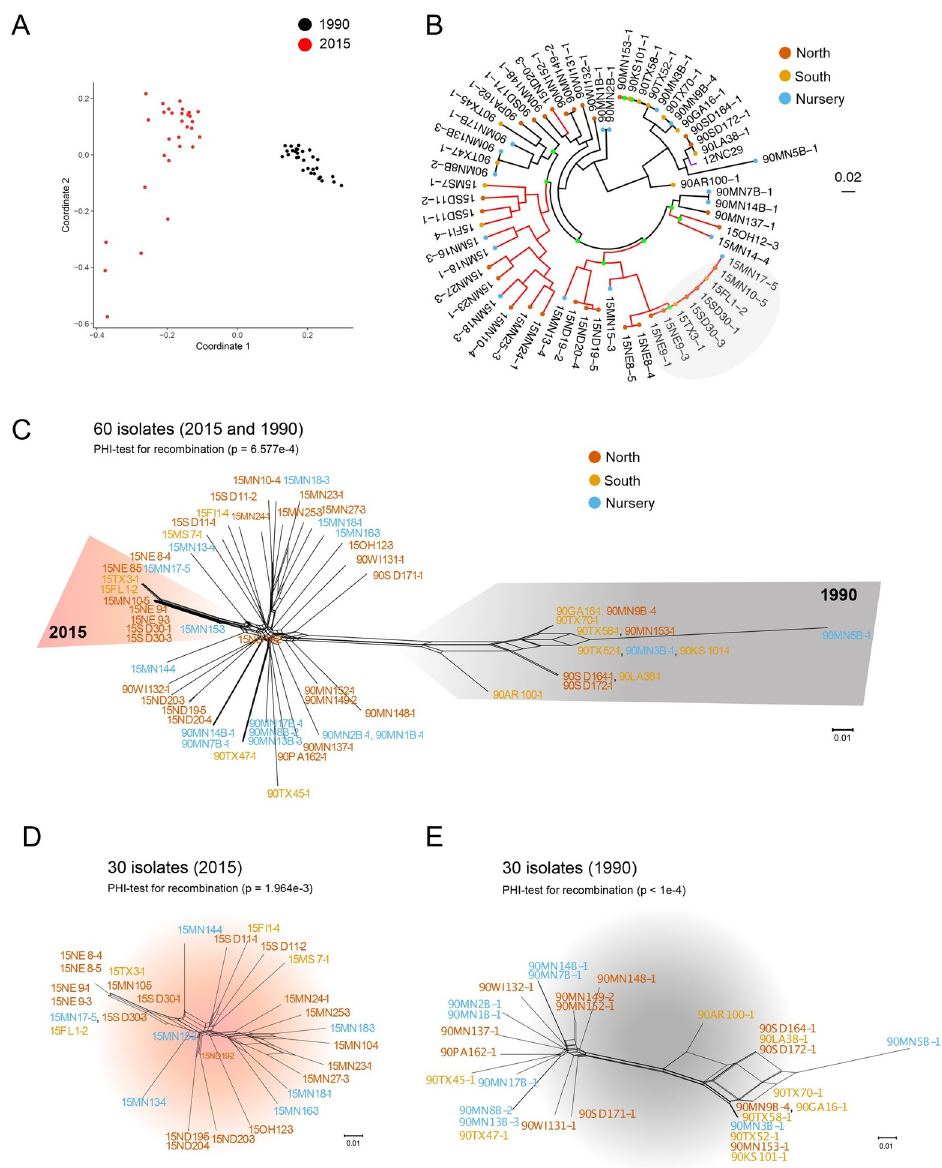
Fig 2. Population structure of Puccinia coronata f. sp. avenae in the US. (A) kWIP Genetic distance matrix of combined isolates from 1990 (black) and 2015 (red) collections. (B) Phylogenetic analysis using a maximum likelihood model with 2,582,690 variant sites and 500 bootstraps. The 1990 population is shown in black branches and the 2015 population is shown in red branches, with a purple branch for isolate 12NC29. Green dots on branches indicate bootstrap support of less than 50 percent, and colored dots on the tips of the tree reflect geographic origin if the isolates. Gray circle highlights an incipient clonal lineage. Scale bar indicates nucleotide substitutions per site. (C) Neighbor-net network of all Pca isolates based on 881,118 SNPs. Areas shaded in orange and grey indicate subpopulations belonging to 2015 and 1990 collections, respectively. PHI-score for recombination is also indicated. Color font in names of isolates reflect geographic origin. (D) Neighbor-net network of Pca isolates collected in 2015 based on 742,978 SNPs. (E) Neighbor-net network of Pca isolates collected in 1990 based on 912,086 SNPs.